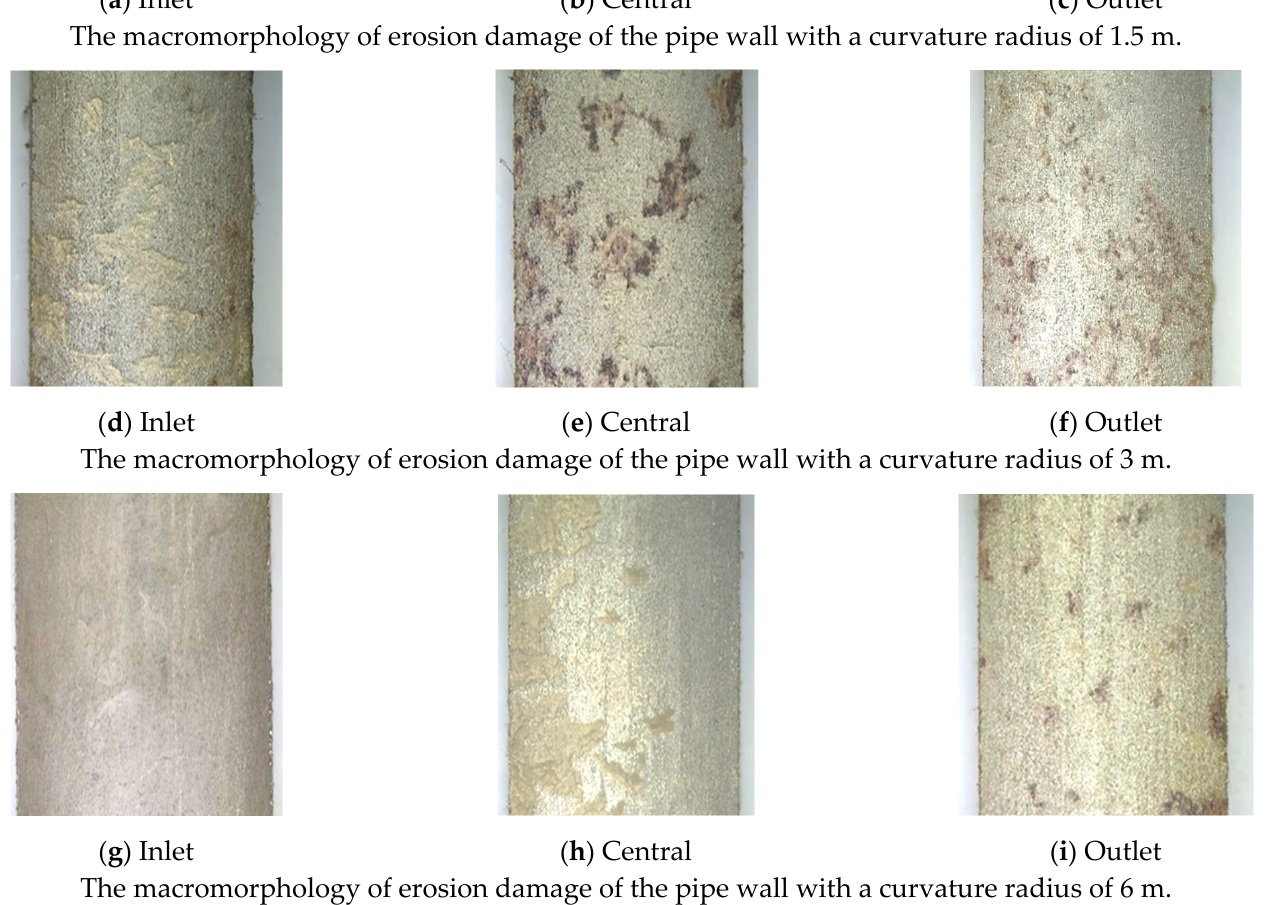
Figure 5. Macroscopic erosion damage of pipes with different radii of curvature.